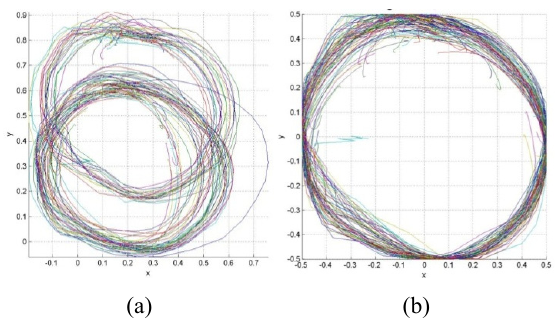
Figure 8. Images of gestures before and after the pre-processing process (a) The initial recording data (b) The data after the pre-processing